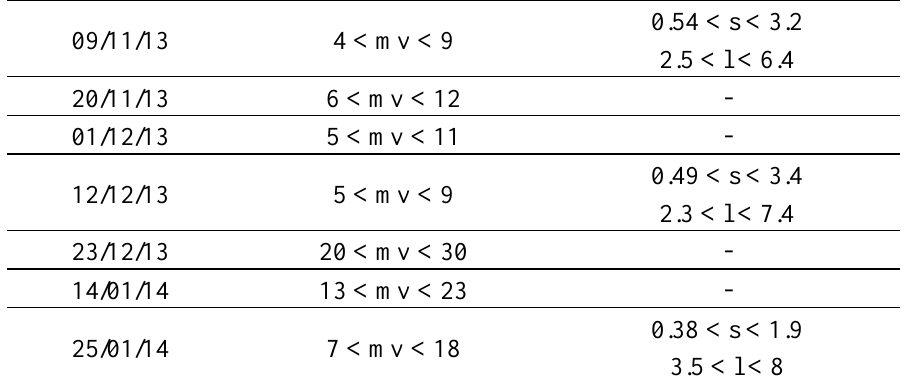
Table 2. Ground measurements (volumetric moisture “mv” and roughness) ranges during experimental